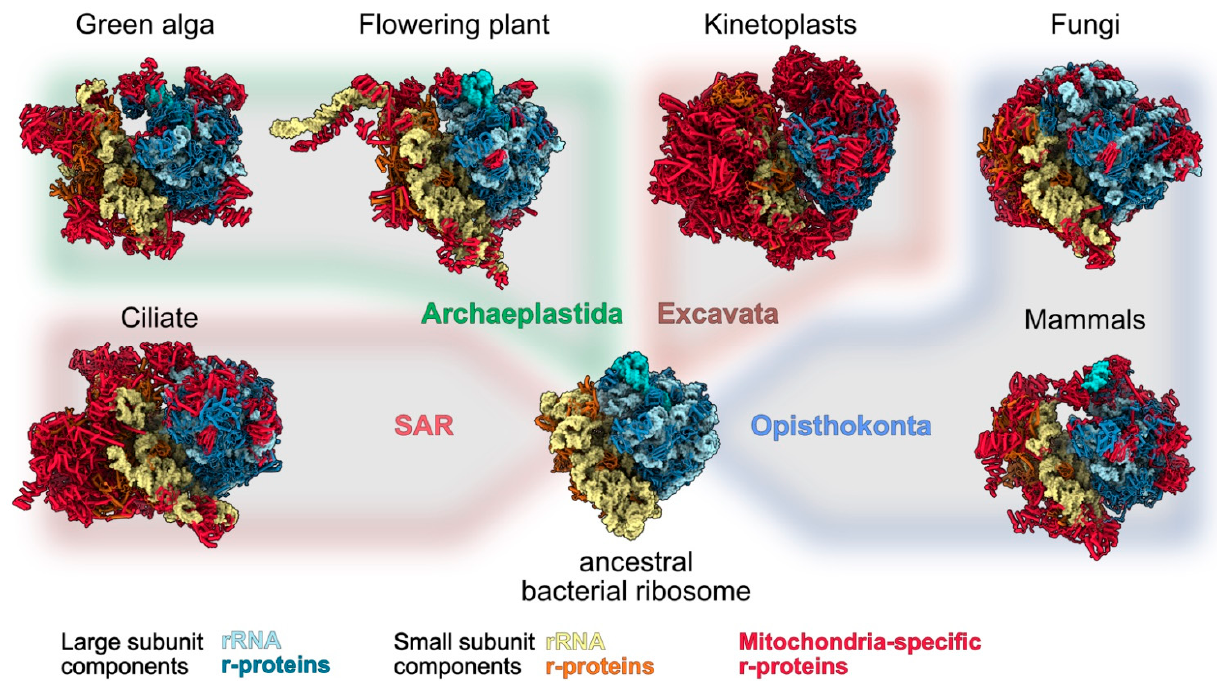
Figure 1. Structural comparison between available mitoribosome structures. To highlight the divergence of mitoribosomes as compared to bacteria and their diversity in terms of size and shape across eukaryotes, high resolution structures of mitoribosomes are presented and overlaid on a schematic evolutionary tree of eukaryotes. From left to right, mitoribosomes structures are from: ciliate ( T. thermophilus ), green alga ( C. reinhardtii ), flowering plant ( A. thaliana ), kinetoplasts ( T. brucei ), fungi ( N. crassa ) and mammals ( H. sapiens ). They are compared with E. coli ribosome structure, representing the ancestral form of mitoribosomes. Large subunits components are shown in blue shades and small subunit components in yellow shades. Mitochondria-specific ribosomal proteins (which includes shared and species-specific proteins) are highlighted in red. No structures have been solved yet for the supergroup Amoebozoa (hence not shown on the figure). SAR corresponds to the supergroup which includes the Stramenopiles, Alveolates, and Rhizaria subgroups.